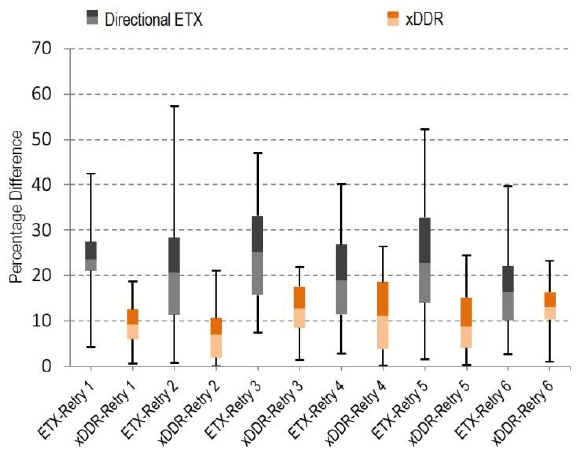
Figure 7: Difference in PDR Estimate and UDP Delivery Ratio